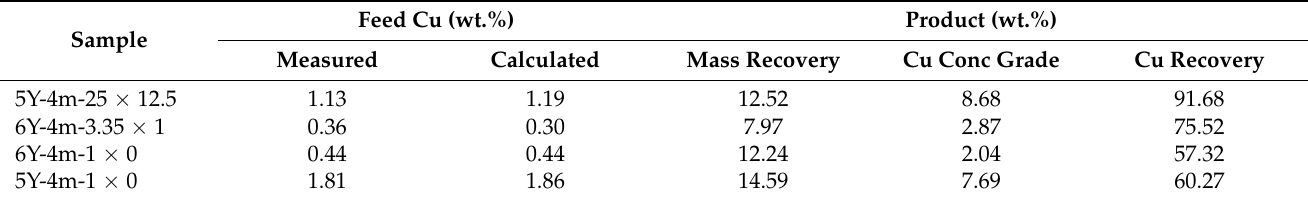
Table 7. Summary of results of the four flotation samples selected for SEM analysis. Sample